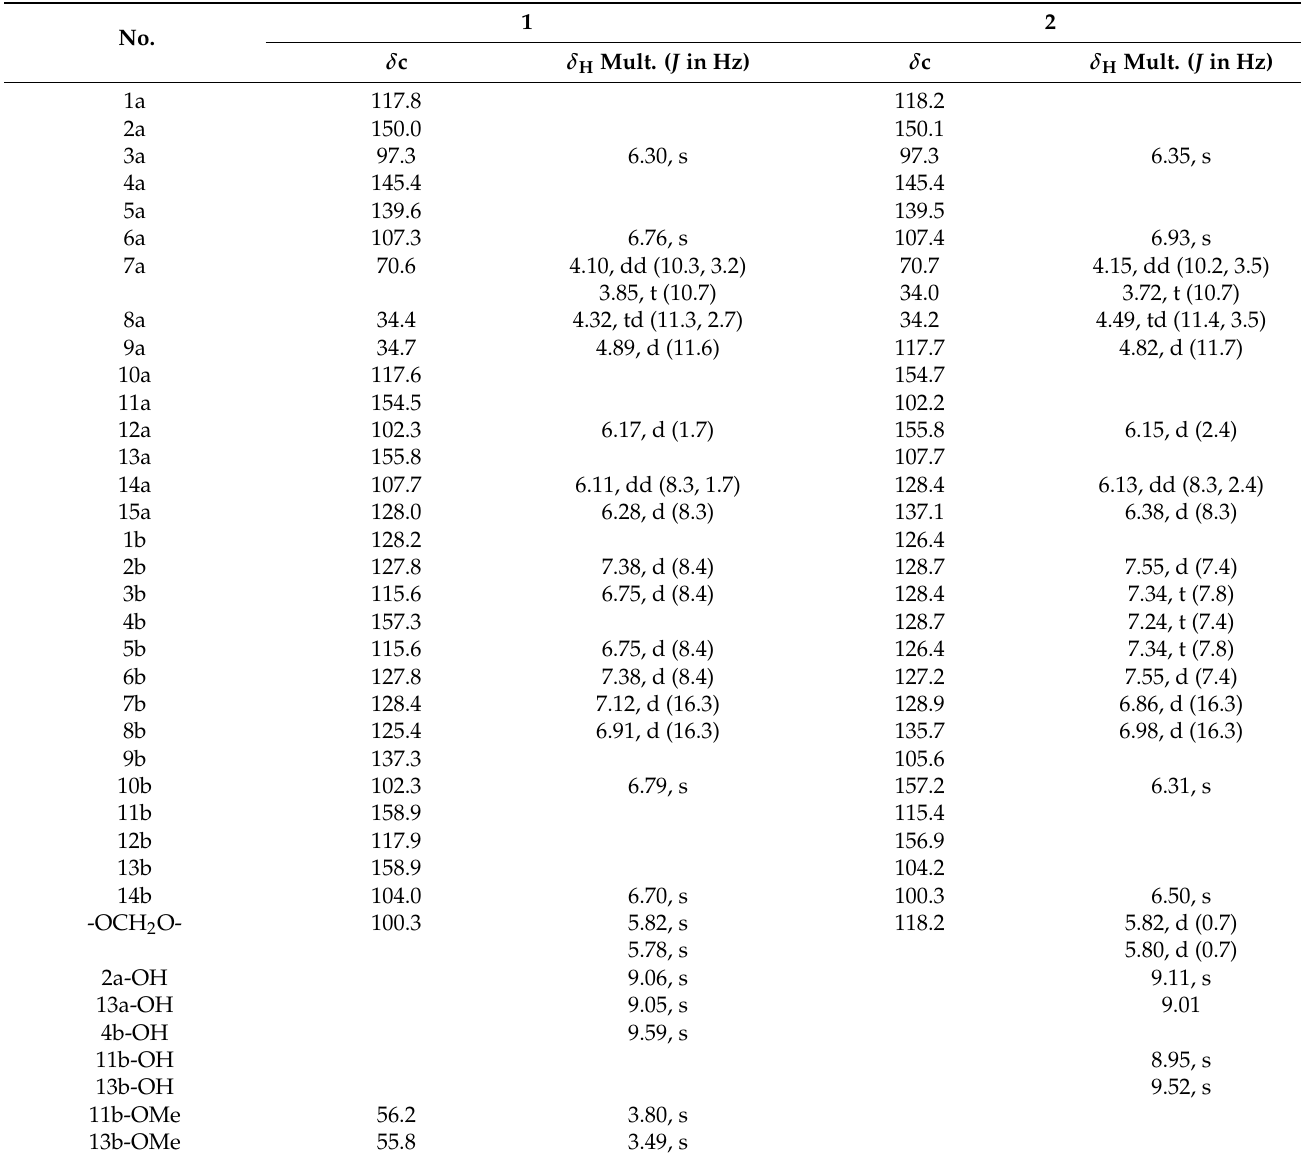
Table 1. 1 H and 13 C NMR data of compounds 1 and 2 ( δ H in ppm, J in